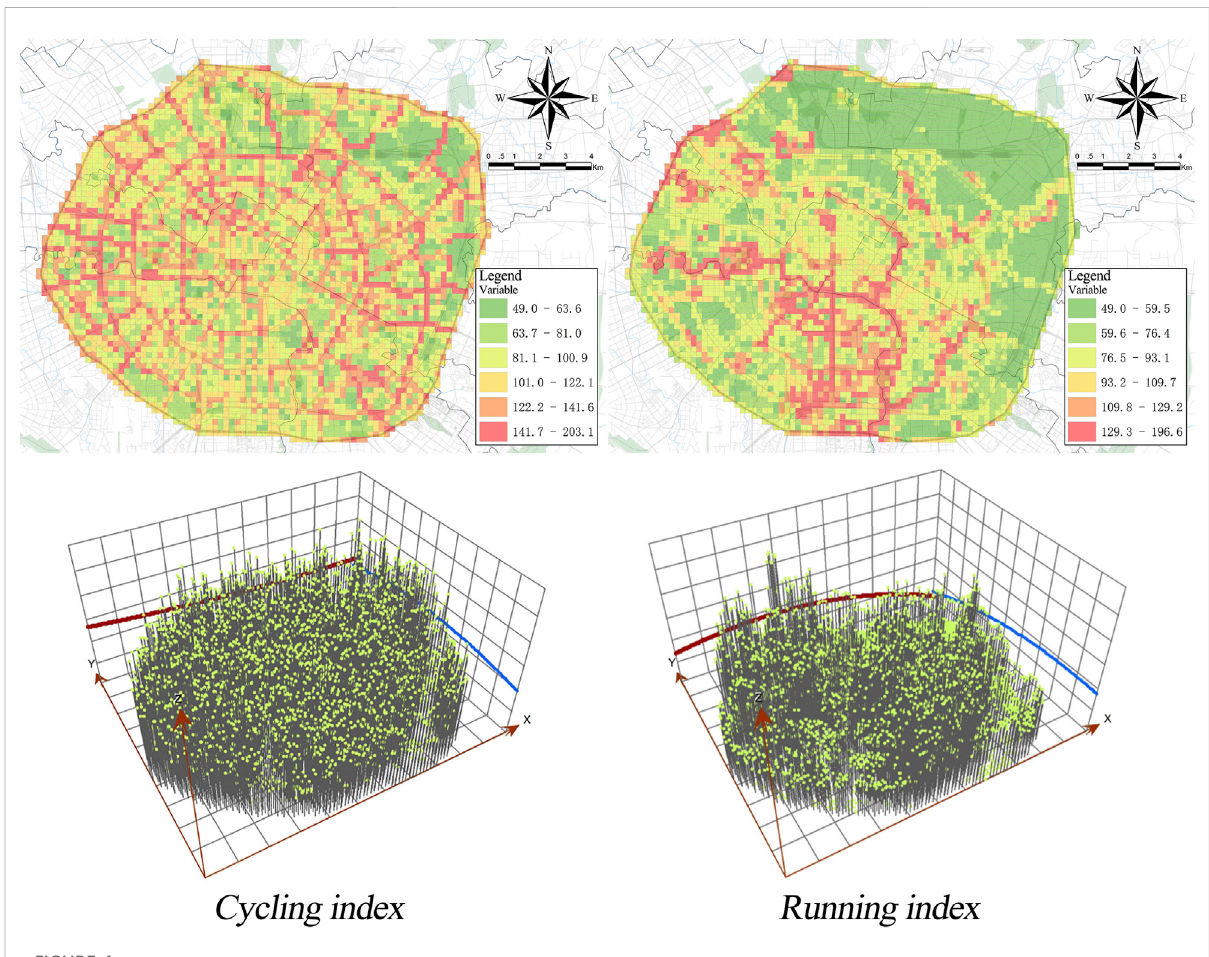
FIGURE 4 Spatial distribution of the cycling index and running index from Strava